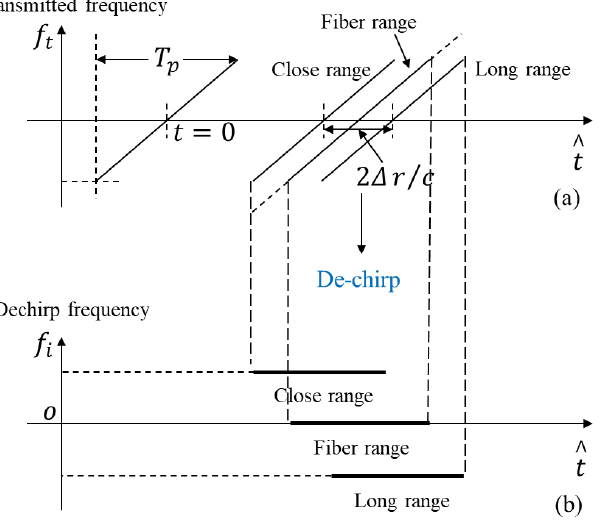
Figure 1. The schematic diagram of dechirp process: ( a ) the transmitted frequencies, ( b ) the dechirp frequency after coherent detection process.